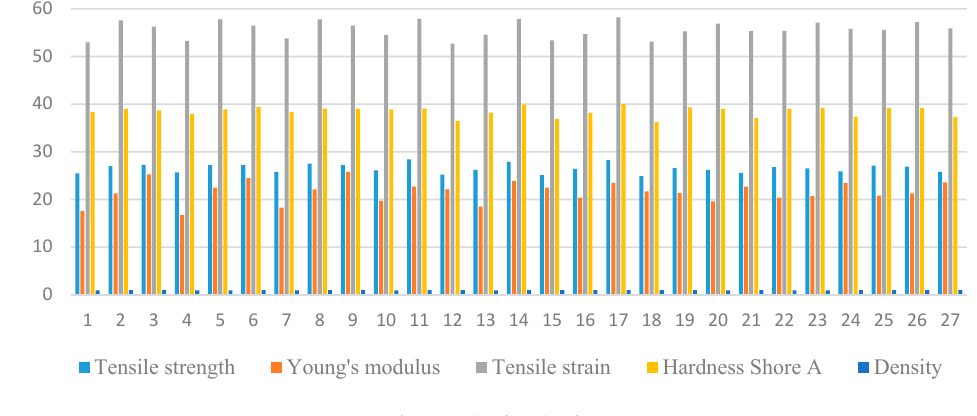
Figure 3. S/N results for the five responses.